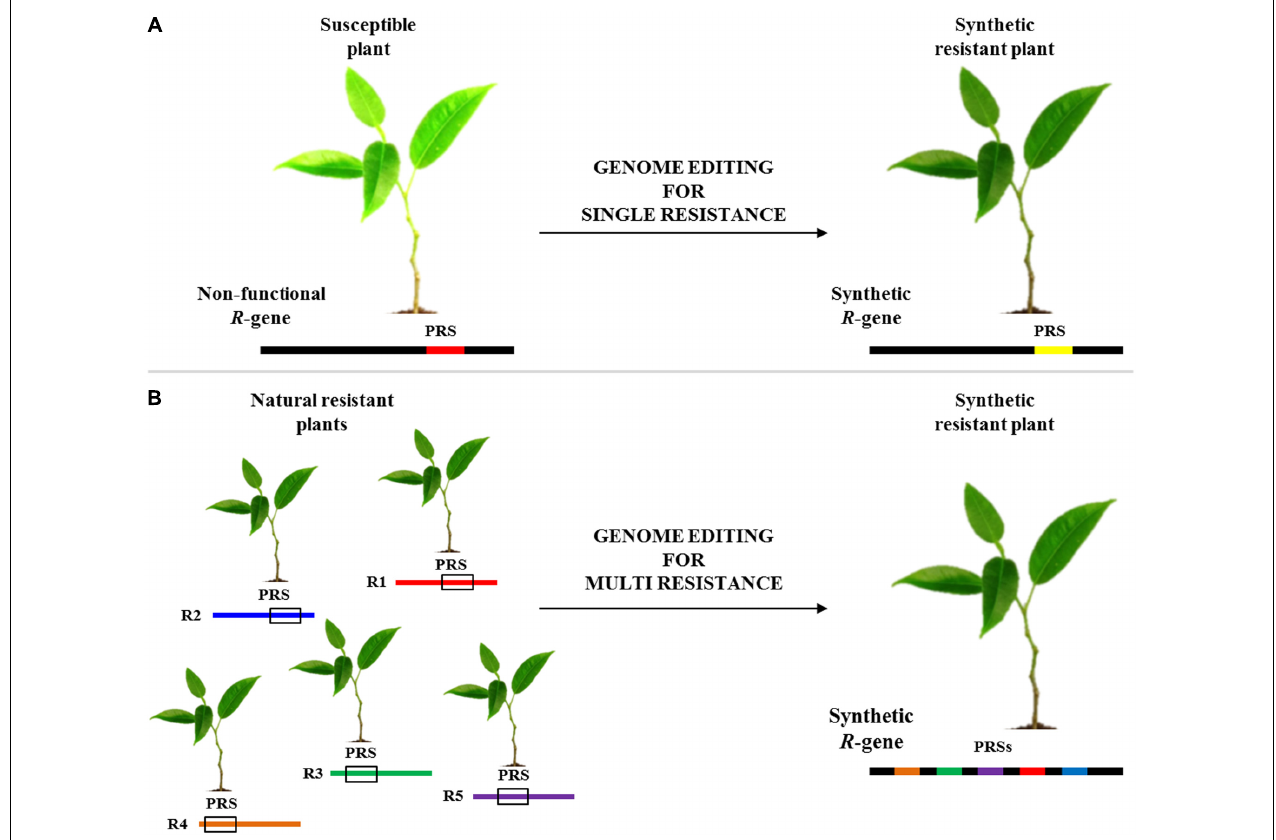
FIGURE 1 | Flowchart of disease resistance genes editing. (A) Modification of a non-functional pathogen recognition site (PRS; red line) to obtain a synthetic functional R -gene (yellow line). (B) Another potential use of editing technology is the engineering of a novel synthetic R -gene able to mount resistance to several pathogens by combining PRS from different R -genes